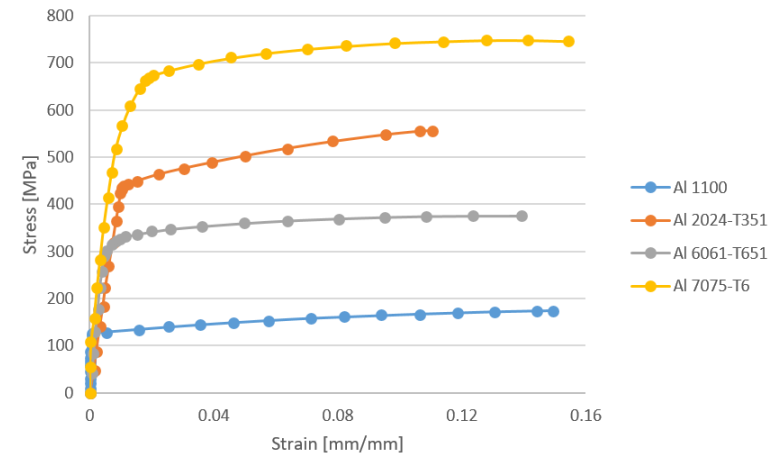
Figure 1. Example of true stress-strain curves of some aluminum alloys (data from Reference